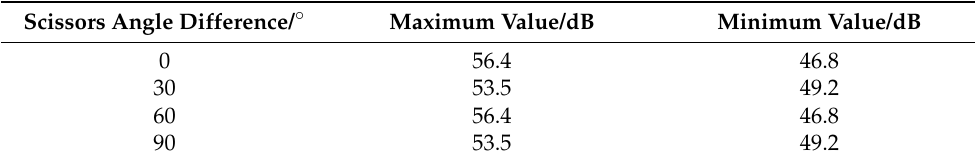
Table 6. Maximum and minimum SPL values at an azimuth angle = 90 ◦ in helicopter mode.